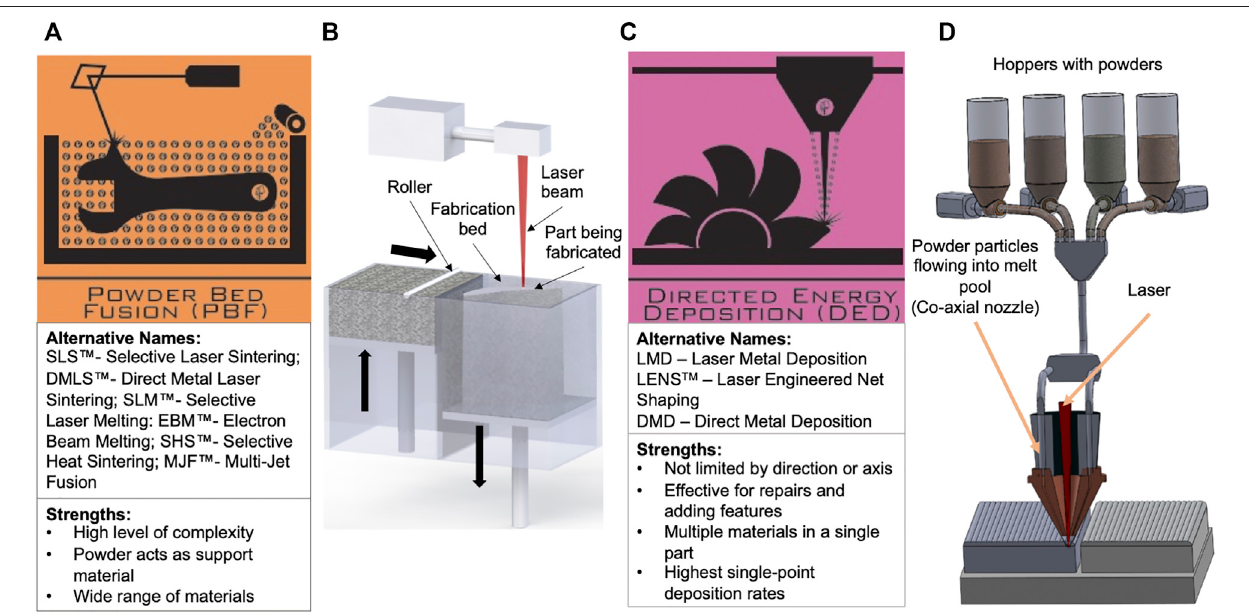
FIGURE 2 | (A , C) An overview of metal additive manufacturing processes according to ASTM (adopted from Hybrid Manufacturing Technologies) (Hybridmanutech, 2020); (B) Schematic of the powder bed fusion process illustrates a roller laying powder on the bed followed by a laser melting the cross section of part; (D) Schematicofdirectenergy(lasermetal)depositiondisplaysthelasermeltingaspotonthesubstratewhiledepositingthepowderintothemeltpool(Sreeramagiri et al., 2020b).